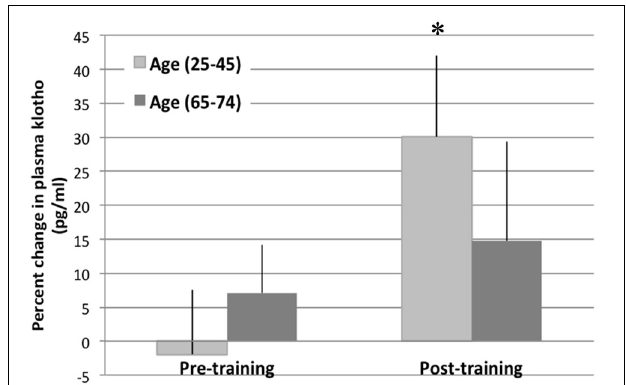
FIGURE 3 | Plasma Klotho levels following an acute bout of exercise in young and older individuals. The change in plasma Klotho levels are depicted at baseline and immediately following an acute exercise bout (pre- and post-training). There was no change in circulating Klotho levels pre-training. However, post-training, there was a significant increase in circulating Klotho levels in the young (age 25–45 years) cohort after an acute bout of exercise. This response was blunted in the older cohort (age 65–74). ∗ denotes significantly different than pre-training values (within age